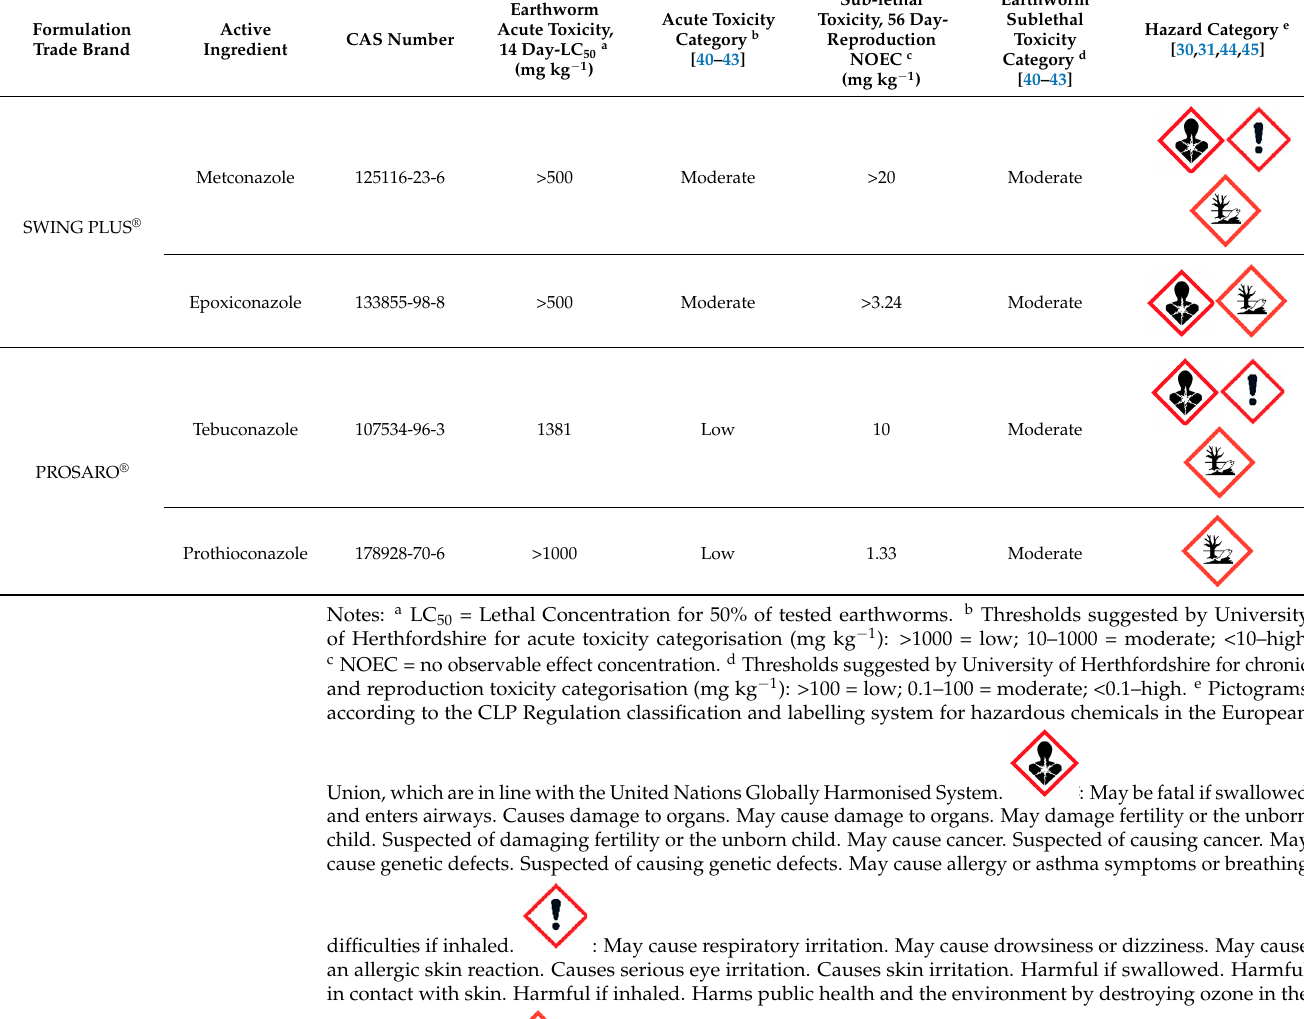
Table 3. Acute lethal and sublethal reproduction toxicities for earthworms ( E. fetida ), the corre- sponding toxicity categories of the active ingredients in the tested fungicides and the health and environment hazard categories.